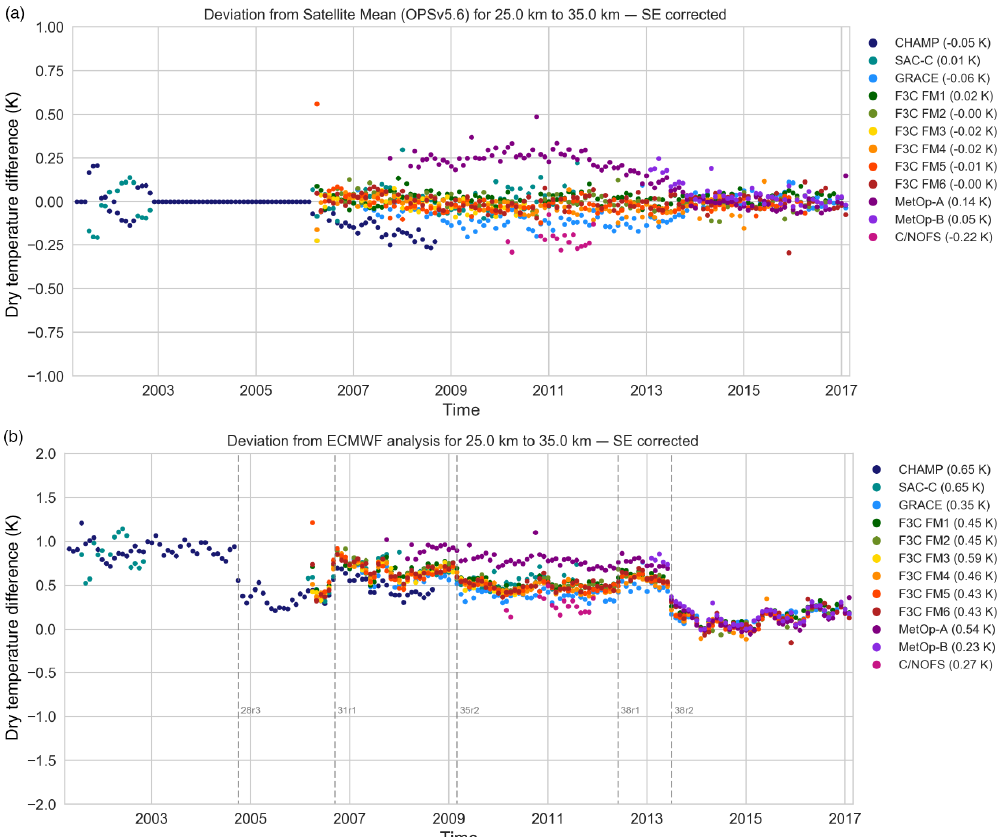
Figure 10. Deviations of individual satellites from the multi-satellite mean (a) and from the ECMWF analysis (b) for monthly mean dry temperature in the altitude layer 25–35km. Points in time (vertical dashed line) mark important ECMWF model system changes (b)